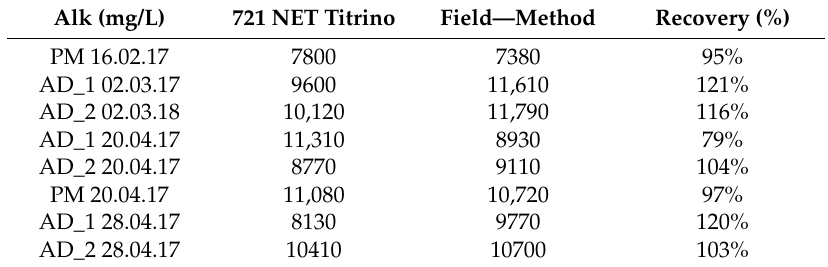
Table A8. Alkalinity titration results, PM—pig manure; AD—anaerobic digestion effluent.